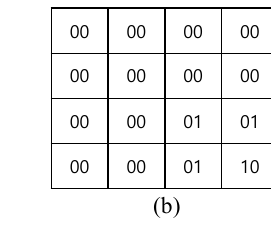
Figure 5. The proposed compress procedure of a block of color AMBTC; ( a ) obtained grayscaled image GI , ( b ) bitmap of the proposed AMBTC MI P